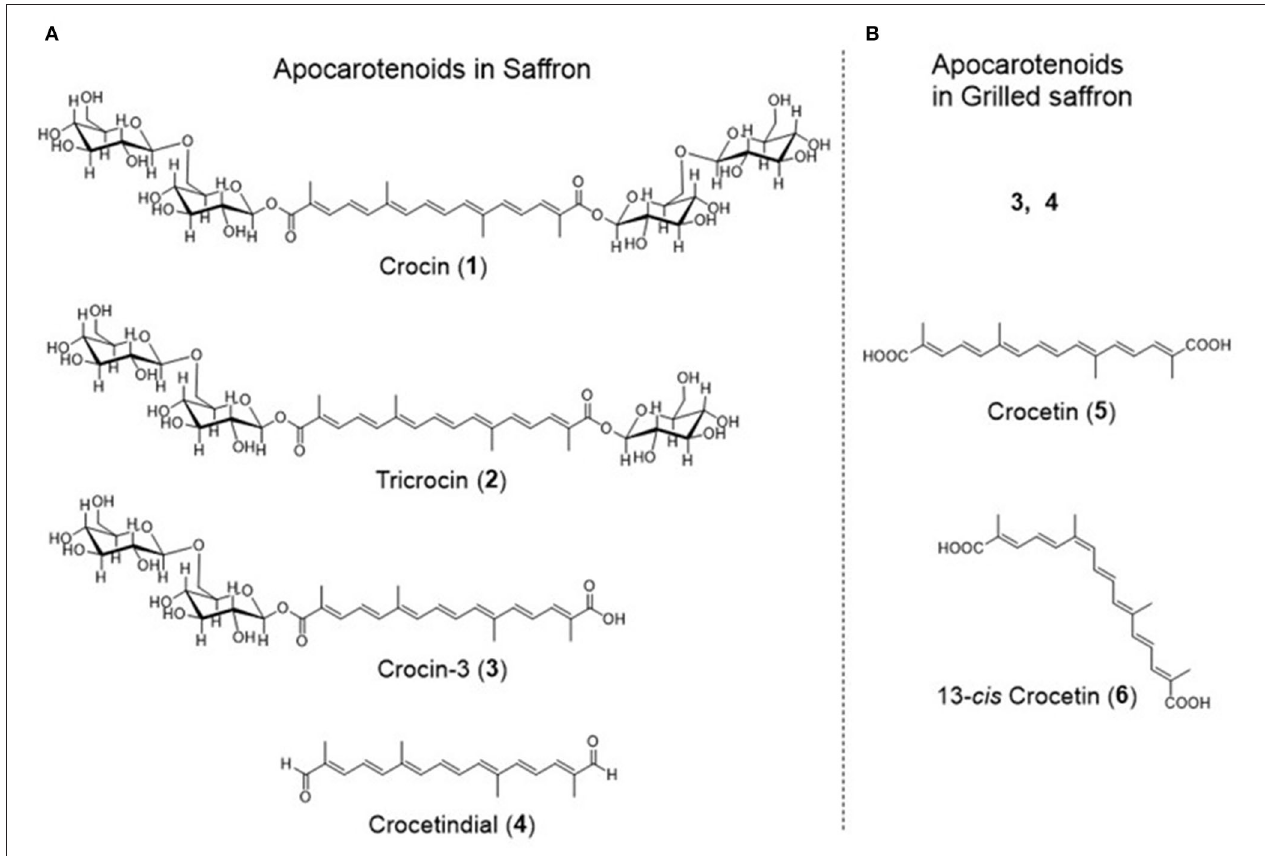
FIGURE 5 | The structures of apocarotenoids in saffron (A) and grilled saffron (B)